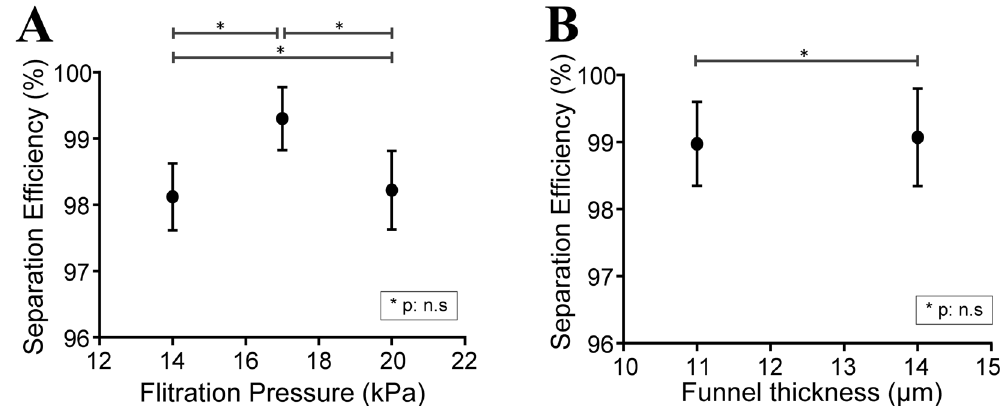
Figure 4. Performance of deformability-based separation of leukocytes from whole blood as a function of ( A ) filtration pressure and ( B ) funnel thickness. (P values determined using Student’s